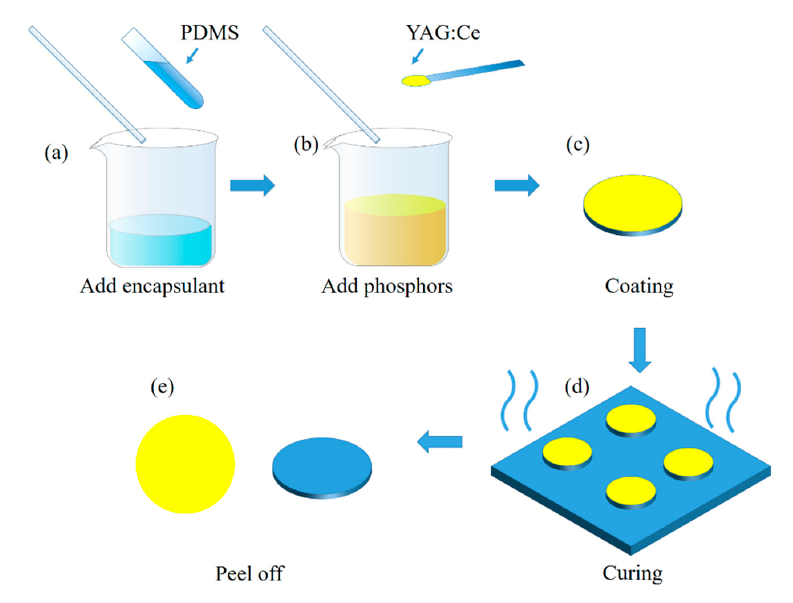
Figure 9. Flow chart for manufacturing phosphor films. ( a ) Adding encapsulant to a beaker. ( b ) Adding phosphors to a beaker and mixing fully. ( c ) Coating phosphor films on the glass substrate. ( d ) Curing in the oven. ( e ) Peeling phosphor films off from the glass substrate.